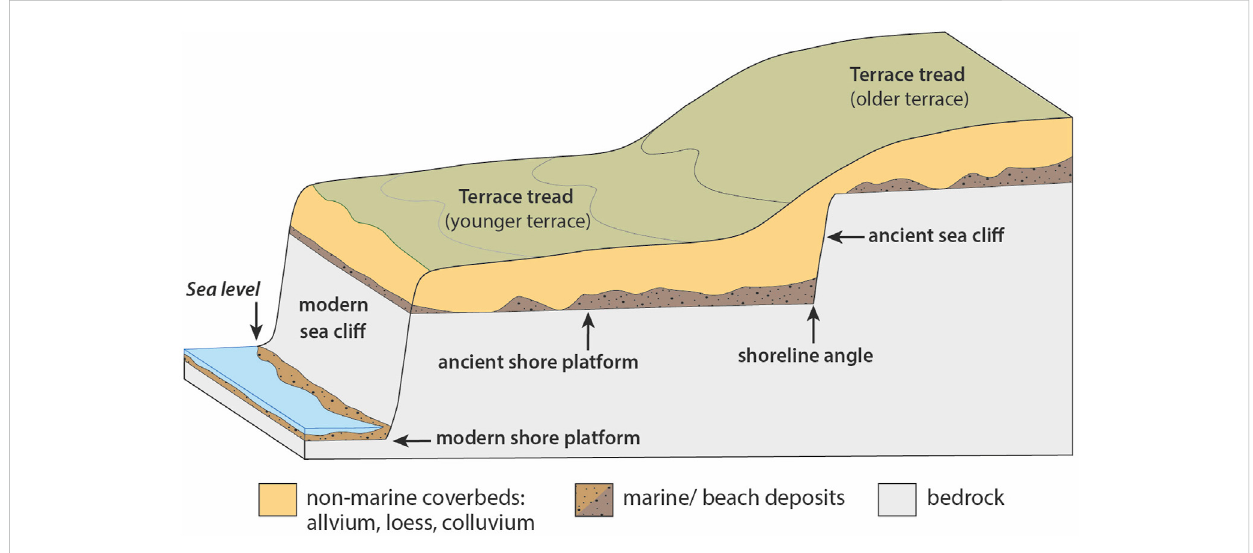
FIGURE 4 Schematicdiagramshowingtypicalgeomorphicandgeologicalfeaturesofmarineterraces.Figuremodi fi edafterPillans(1990).Thicknessofmarine deposits and non-marine coverbeds (e.g., loess, colluvium) are illustrative only - they do not represent true